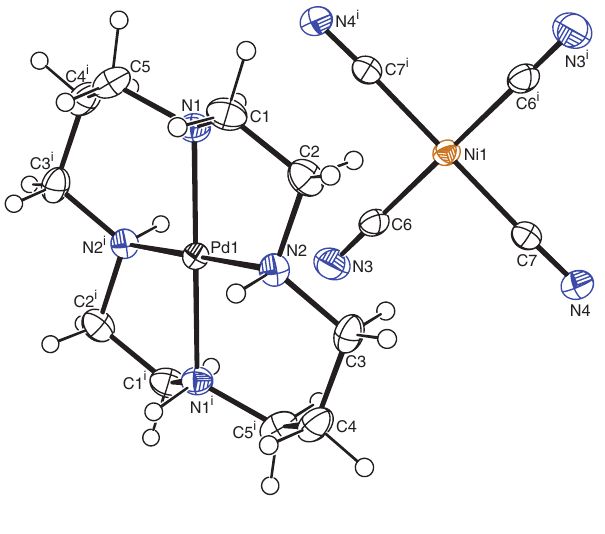
Table 1: Data collection and handling.